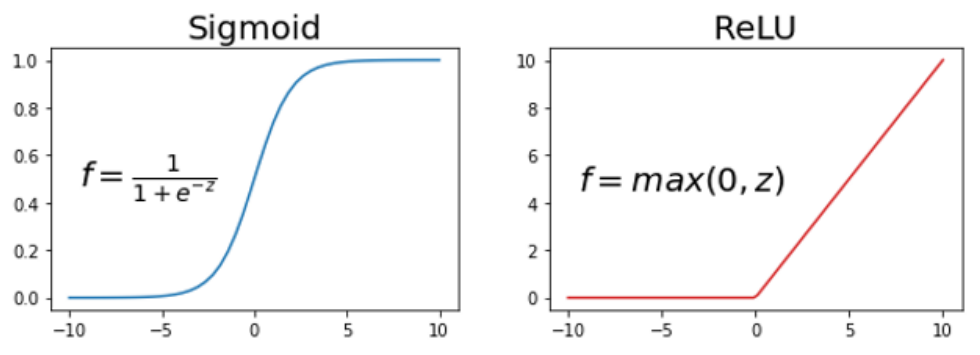
Figure 5. Activation functions: Sigmoid and